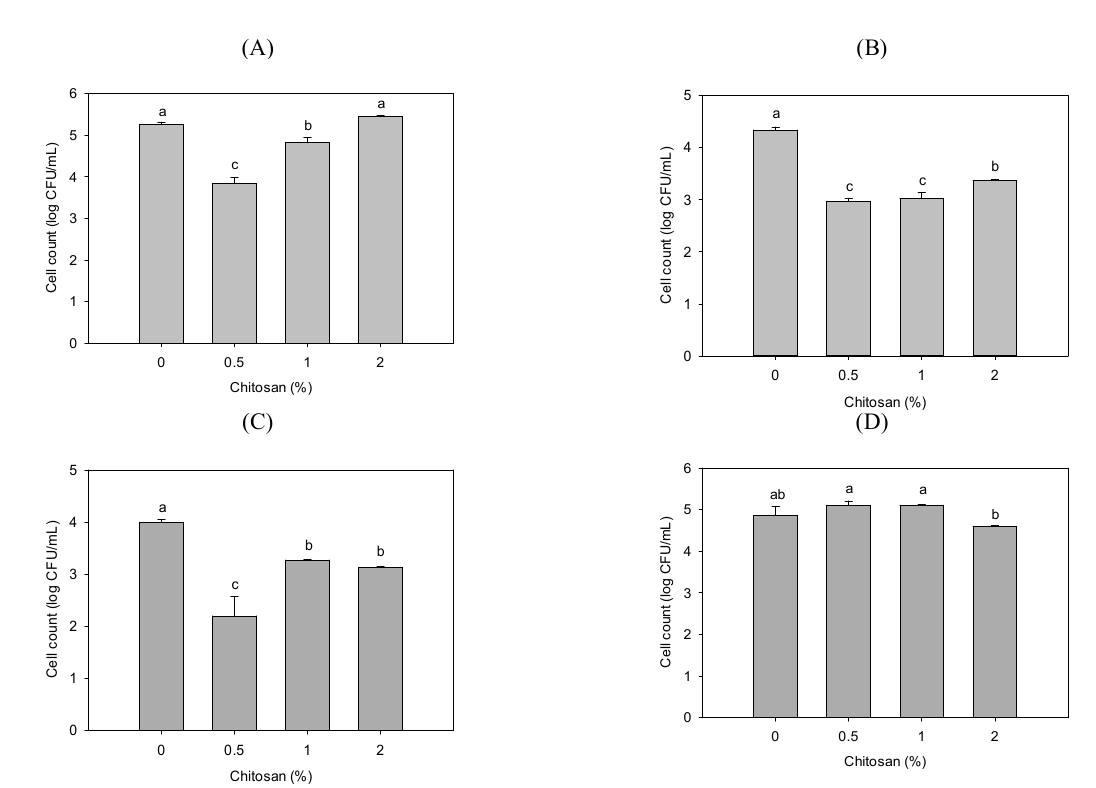
Figure 2. Antibacterial activity of various films of PLA, and PLA containing 0.5%, 1%, and 2% of chitosan against: ( A ) Escherichia coli; ( B ) Staphylococcus aureus ; ( C ) Pseudomonas fluorescens ; and ( D ) Vibrio parahaemolyticus . Data are presented as mean ± SD ( n = 3). Bars with different letters on top are significantly different ( p < 0.05).